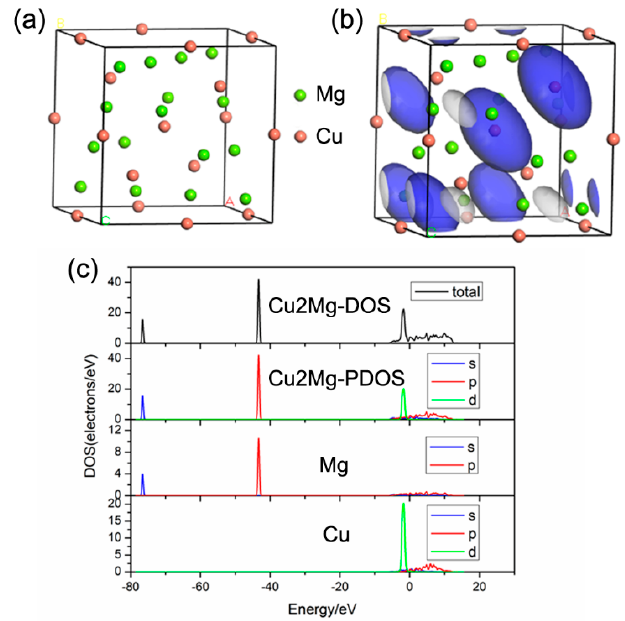
Figure 5. First-principles calculation results of Cu 2 Mg: ( a ) Unit cell model; ( b ) Electron density map; ( c ) State density maps.